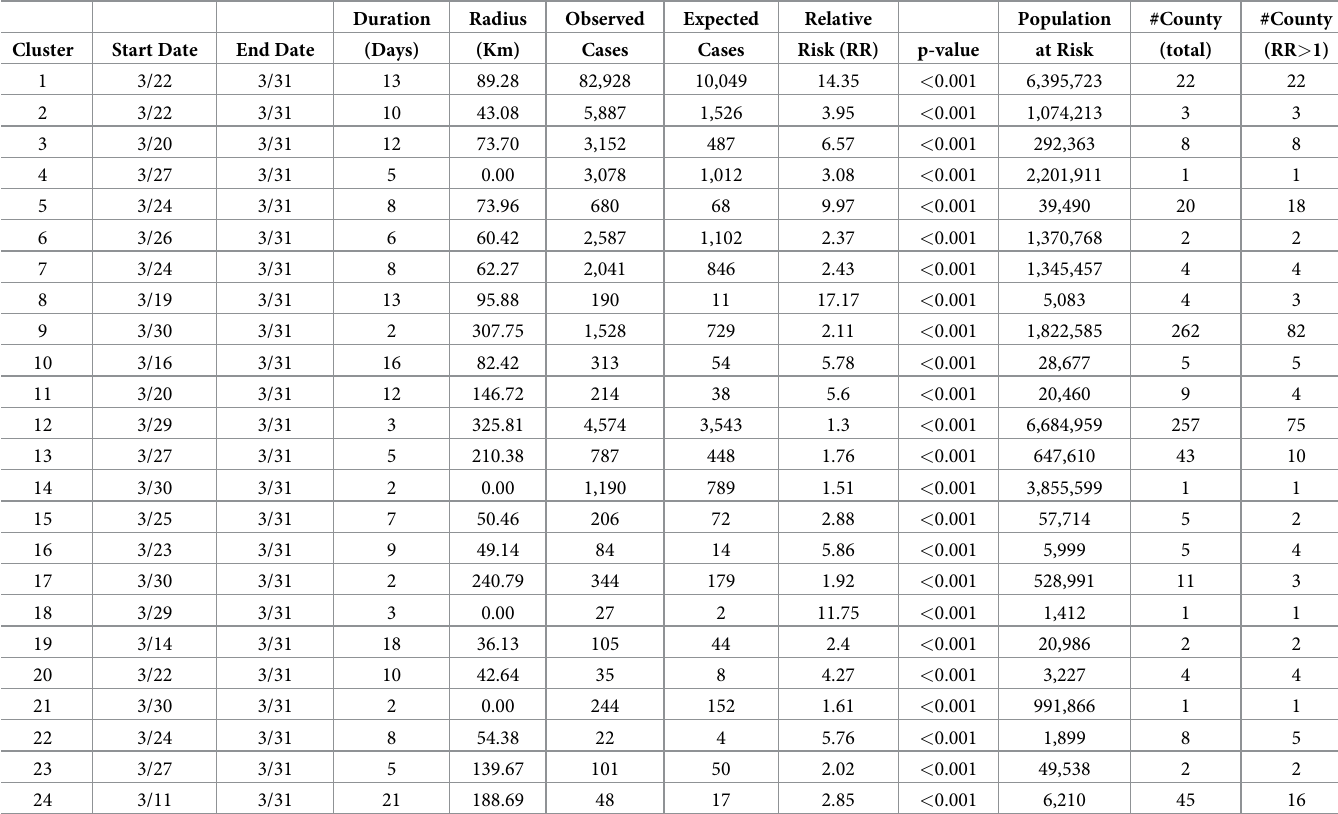
Table 2. Attributes of prospective space-time clusters (hotspots) for COVID-19 from 1/23-3/31/2020 at the county